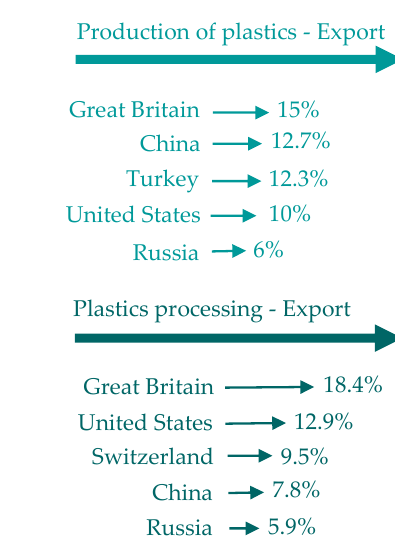
Figure 4. Trade outside the EU in terms of sales value. Made based on [3].